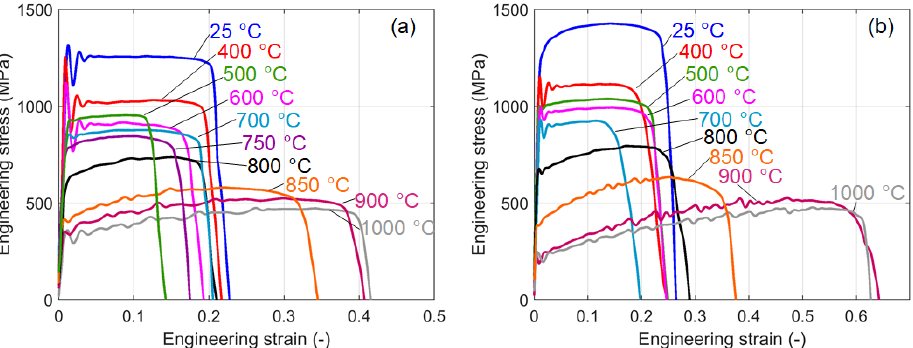
Fig. 5. Engineering stress versus engineering strain curves obtained for high strain rate tests performed on (a) DA and (b) HT specimens in the range of temperatures between 25 and 1000